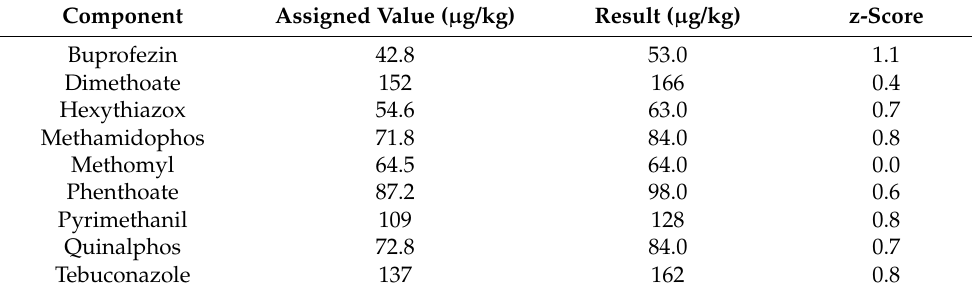
Table 2. Olive oil, proficiency test 5147 (FAPAS), October 2020.